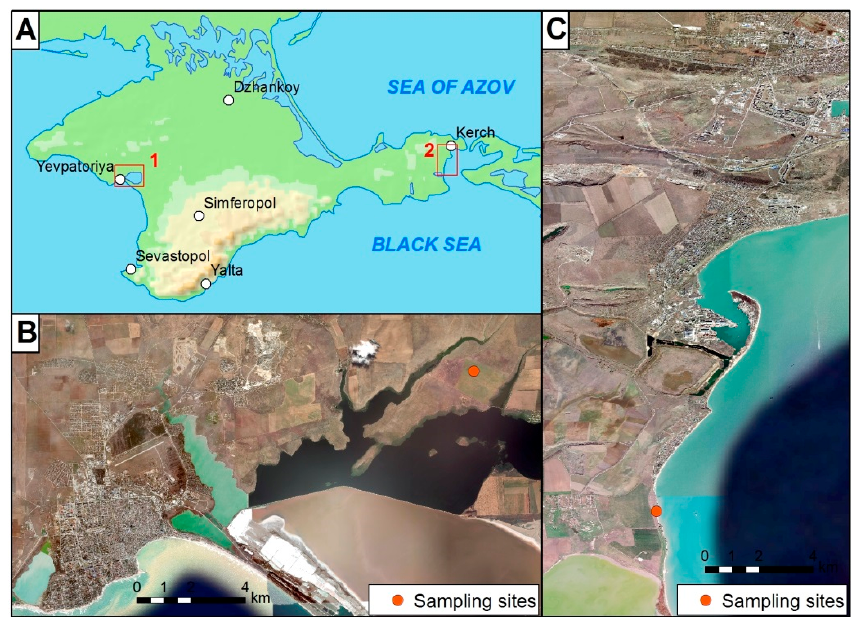
Figure 1. Study area: the first site (15 km north-east of the ancient town of Kerkinitis) and second site (16 km south the ancient town of Bosporos, near the Geroevka-2 settlement) ( A ), soil sampling location on the first site ( B ), soil sampling location on the second site ( C ). Satellite imagery mosaic source—ESRI World Imagery.